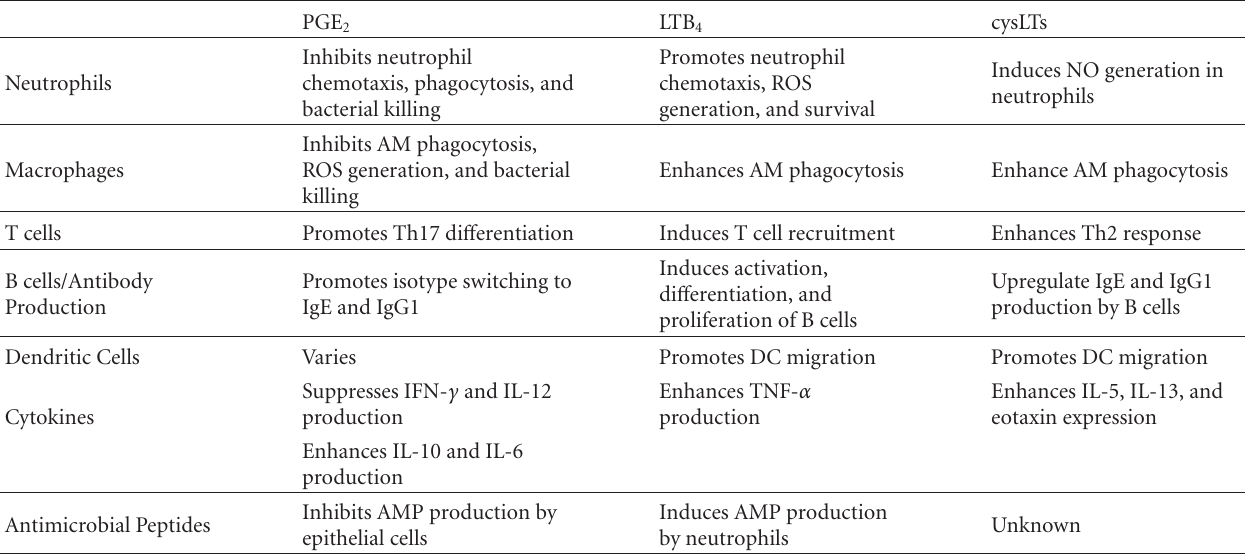
Table 1: E ff ects of PGE 2 and leukotrienes on immune